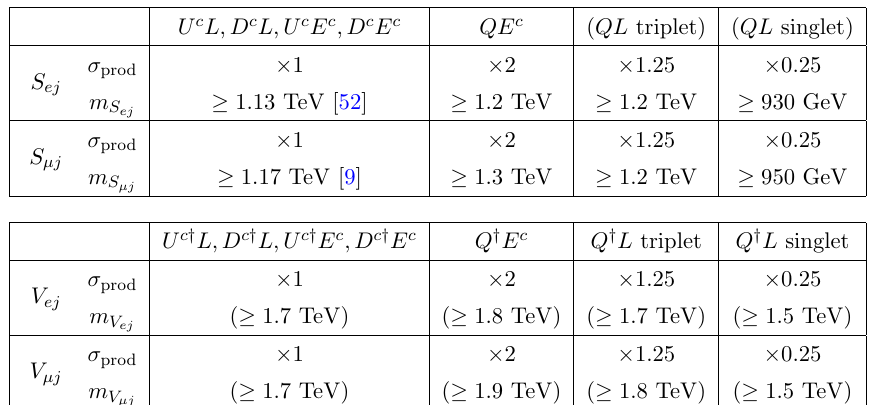
Table 5 . ( Upper table ) 95% CL lower limits on the masses of the scalar MLQs S mass bounds in the (cid:12)rst column are from [52] and [9] while the mass bounds in the remaining columns are our recasts, which use our (cid:22) -factors and the experimental bounds on the production cross section from [52] and [9] respectively. The SM fermions involved in the couplings are the (cid:12)rst- or second-generation quarks and electrons or muons. ( Lower table ) 95% CL recast lower limits on the masses of vector leptoquarks V ej and V (cid:22)j